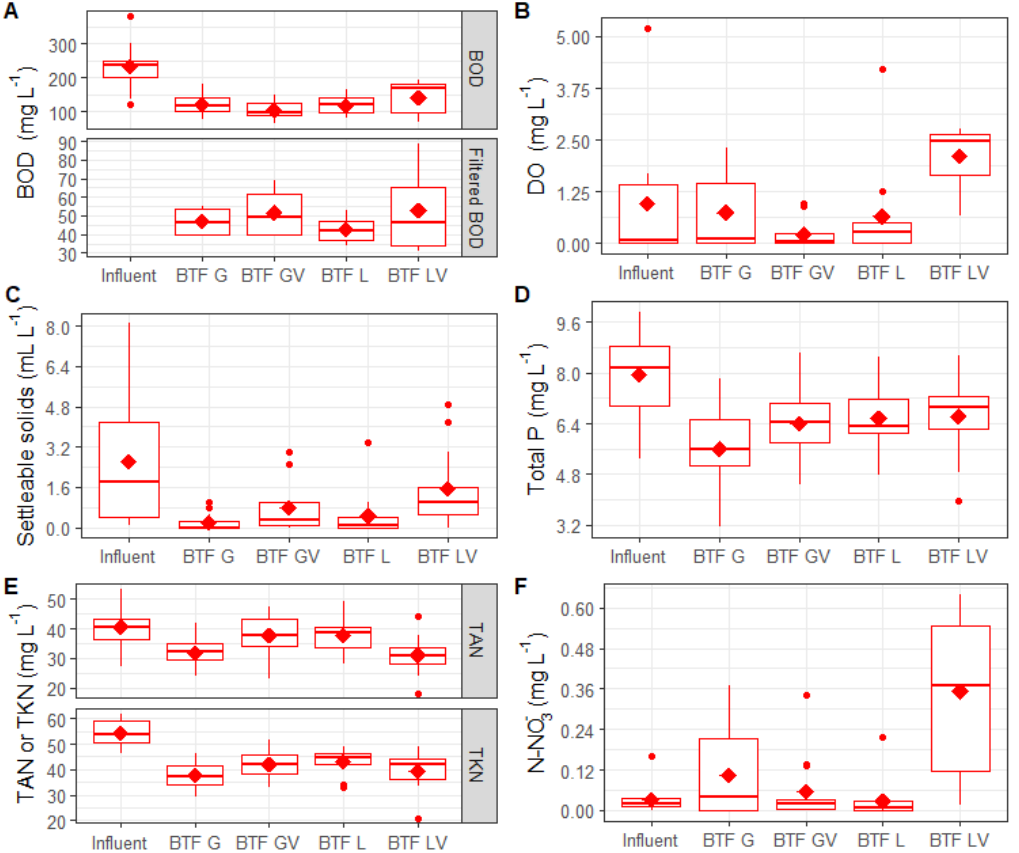
Figure 2. Box plot of filtered and not filtered BOD ( A ), DO ( B ), settleable solids ( C ), total phosphorus ( D ) and TKN/TAN ( E ) and N-NO 3 − ( F ) in each BTF unit.